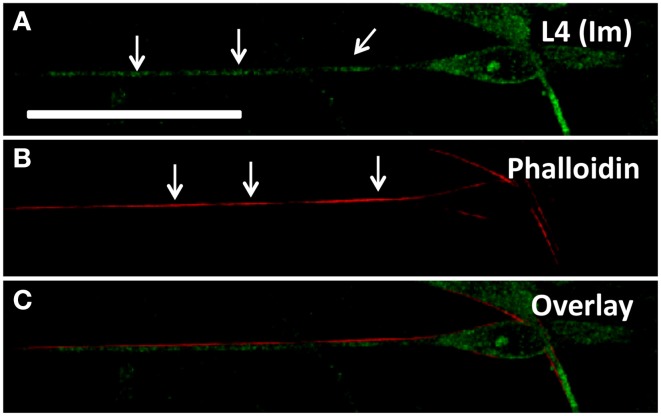
(A) Schwann cell immunostained for L4 shows expression throughout the projection with specifically punctate regions (arrows) corresponding to ribosomal rich regions; (B) Phalloidin staining highlights cortical regions rich in actin (arrows) but not necessarily corresponding with ribosomal rich regions (C). Scale bar: 50 μm.